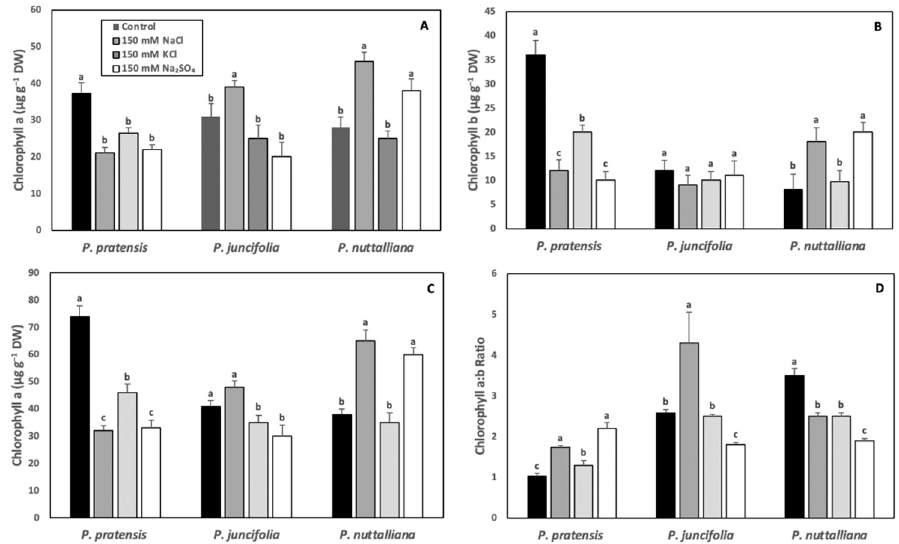
Figure 3. Leaf chlorophyll a ( A ), chlorophyll b ( B ), and total chlorophyll ( C ) concentrations, and chlorophyll a:b ratios ( D ) in Poa pratensis , Poa juncifolia , and Puccinellia nuttalliana subjected to six days of treatments with 150 mM NaCl, 150 mM KCl, 150 mM Na 2 SO 4 and in untreated control plants. Different letters above the bars indicate significant differences ( p ≤ 0.05) between treatments within each species as determined by the Tukey’s test. Means ( n = 6) and SE are shown.